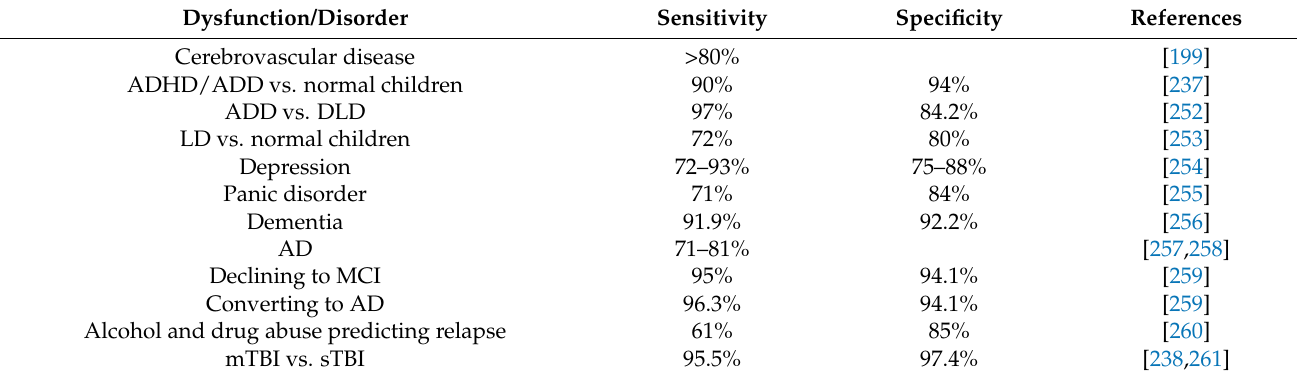
Table 1. qEEG-based detection/discrimination of patients with specific